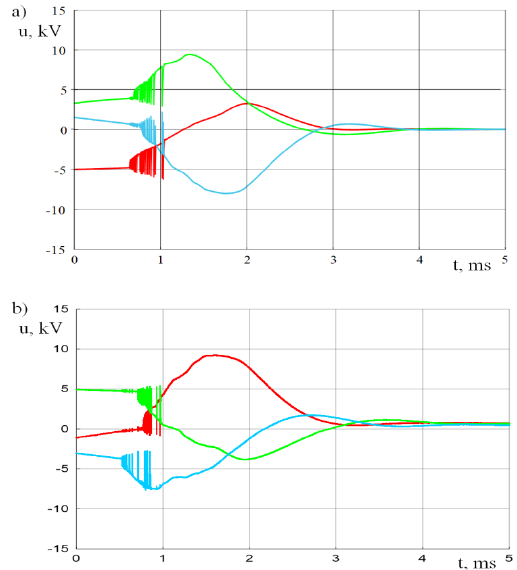
Figure 5. Transient overvoltage waveforms at transformer terminals Tr (Figure 3) switched off with a vacuum circuit breaker wb connected to the transformer by a 2 m long cable line lc: ( a ) — system with surge arresters, ( b ) — system without surge arresters.